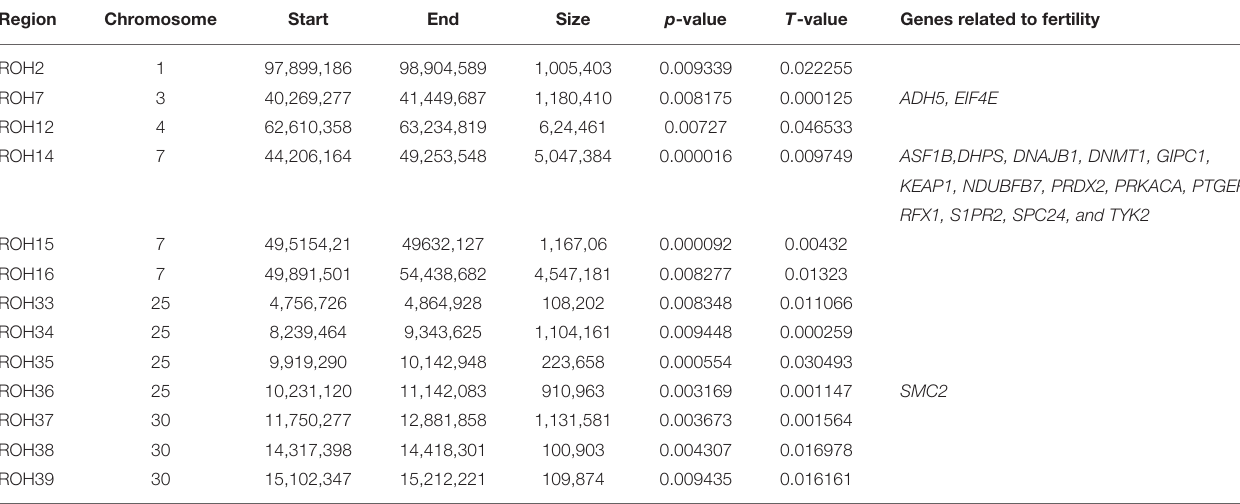
TABLE 1 | ROH islands significantly associated with Re dEBV validated in the whole population ( n = 862). Region Chromosome Start End Size p -value T -value Genes related to